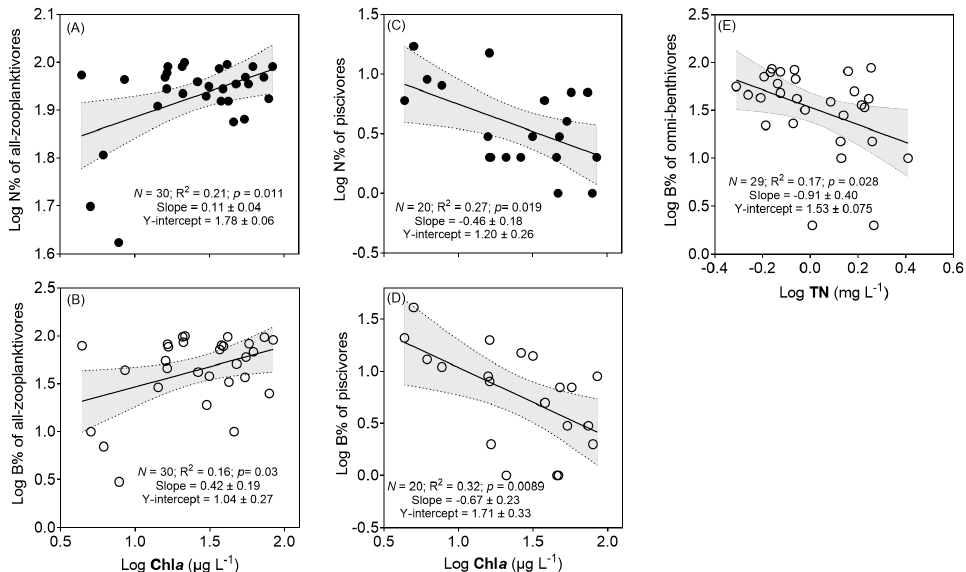
Figure 6. Percent abundance (N%) and biomass (B%) of all zooplanktivores (zooplanktivores + omniplanktivores ( A , B )) and piscivores ( C , D ) along the Chl a gradient and of omnibenthivores ( E ) along the TN gradient. N , number of lakes; Chl a , chlorophyll- a concentration in phytoplankton. The dashed lines represent the 95% confidence band.- 3.8. Relationships between the Catch of Three Dominant Species and Piscivorous Fish and Chla Chl a of phytoplankton was the best explanatory variable for both NPUE and BPUE of three dominant fish species from different trophic groups and the piscivorous Culter spp. (Table 2). Both NPUE and BPUE of T. swinhonis increased markedly with Chl a (Figure 7). Similarly, NPUE and BPUE of H. leucisculus demonstrated a significant positive linear correlation with Chl a (Figure 7). In addition, both NPUE and BPUE of the omnibenthivorous C. carassius increased markedly with Chl a (Figure 7). Contrary to the proportional decline of piscivores with Chl a , NPUE and BPUE of Culter spp. increased markedly with Chl a (Figure 7).